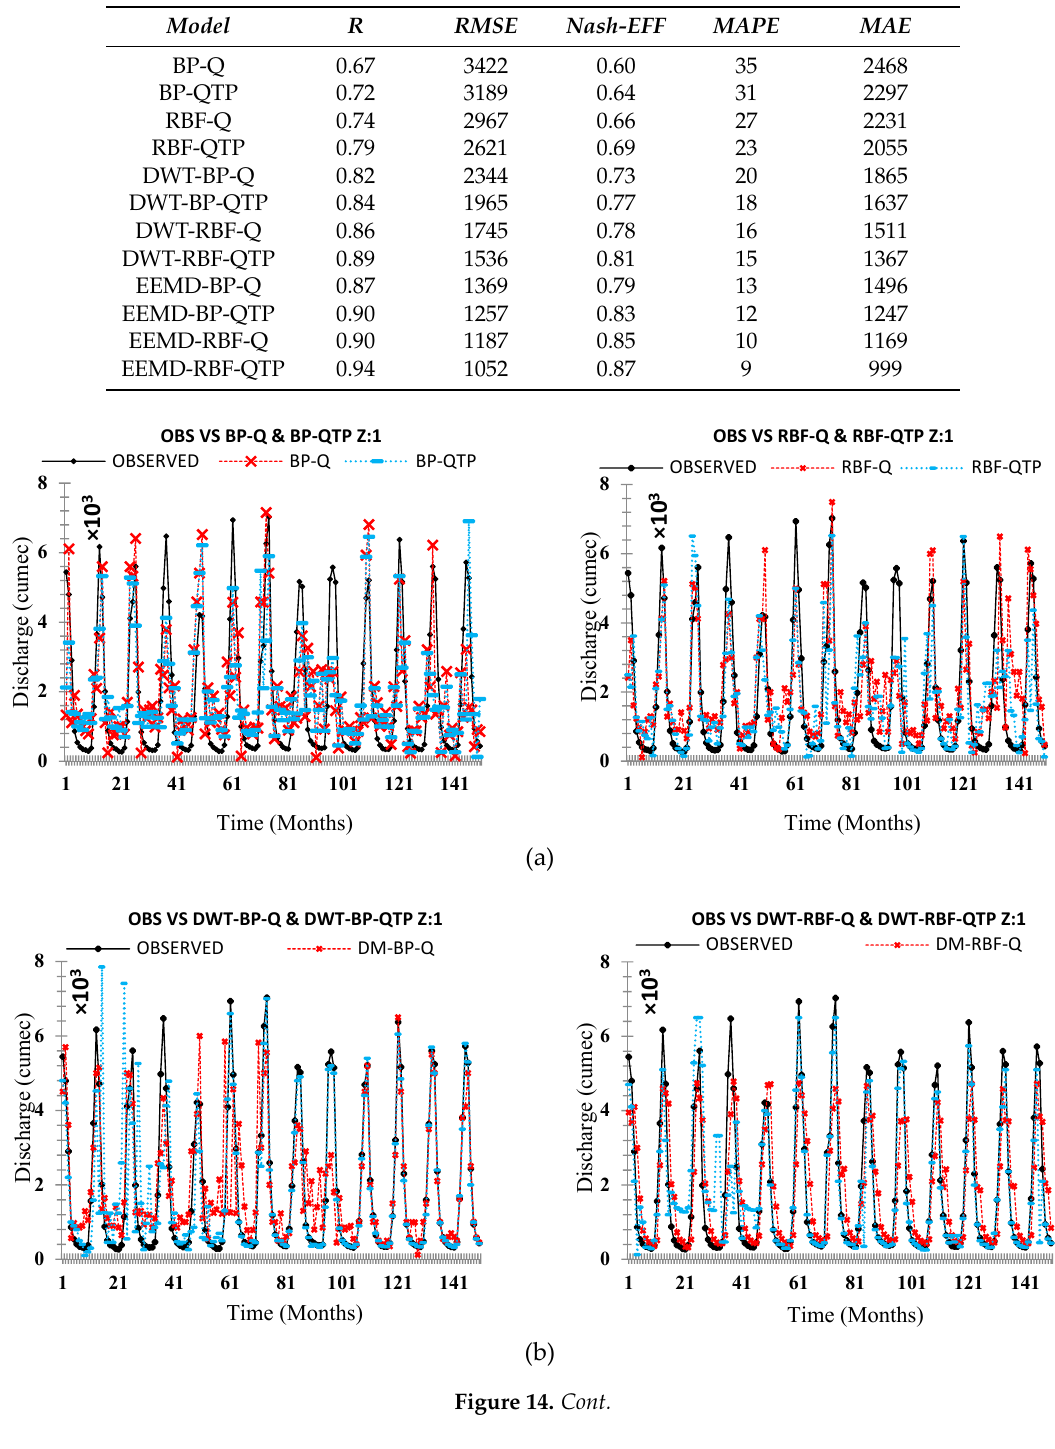
Table 11. Performance evaluation of the applied models for zone three during the validation period.